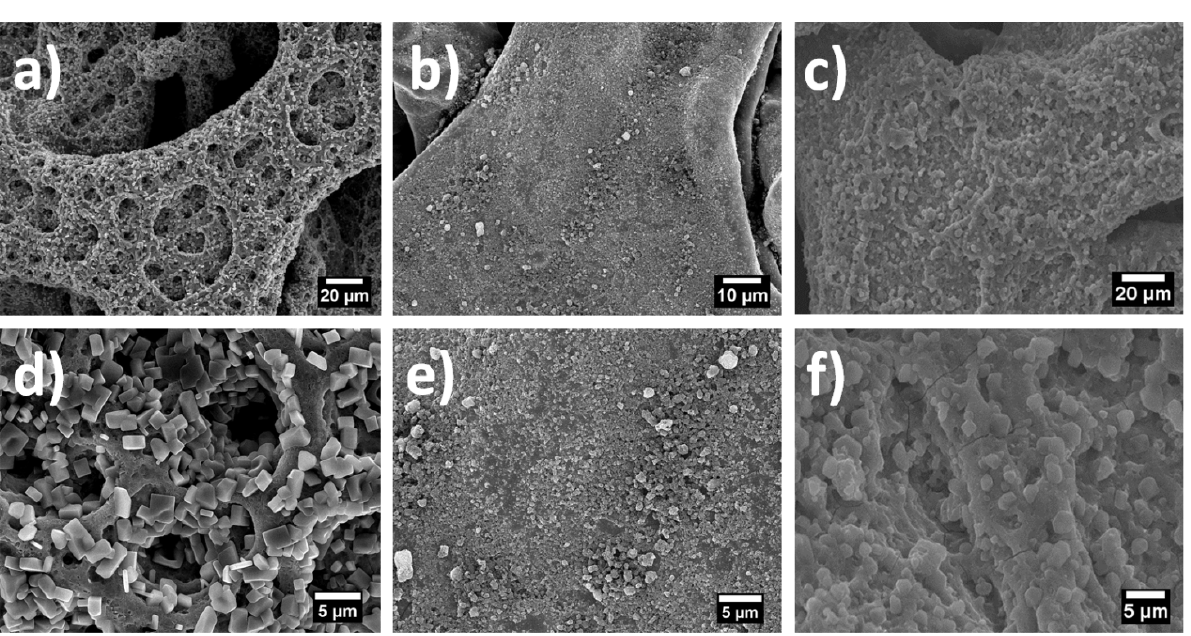
Figure 1. SEM images of ( a ) as-deposited tin oxide; ( b ) as-deposited grapheme; ( c ) as-deposited Tin oxide/graphene (TG) deposited; ( d ) heat-treated tin-oxide; ( e ) heat-treated grapheme; ( f ) heat treated TG